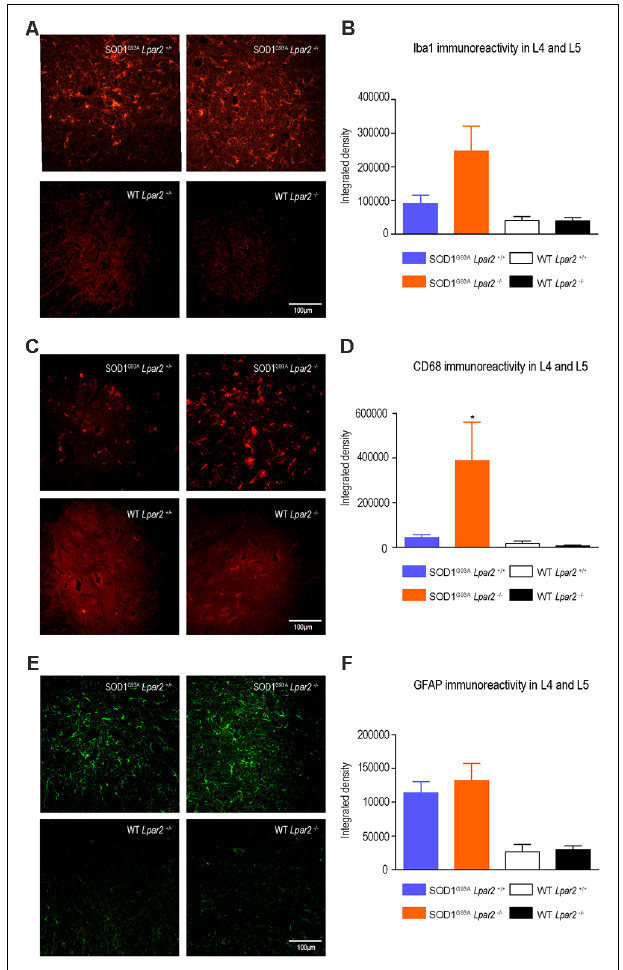
FIGURE 4 | The lack of Lpar2 does not reduce astrogliosis and microgliosis in the lumbar spinal cord of SOD1 G93A mice. (A) Representative images of the lumbar spinal cord stained against Iba1. (B) Plot showing the quantification of the Iba1 immunoreactivity in the L4 and L5 spinal cord segments. (C) Representative images of the lumbar spinal cord showing stained against CD68. (D) Graph showing quantification of CD68 immunoreactivity in the L4 and L5 segments. (E) Representative images of the lumbar spinal cord showing stained against GFAP. (F) Graph showing quantification of GFAP immunoreactivity in the L4 and L5 segments. One-way ANOVA, Bonferroni’s post hoc test. * p < 0.05 vs. SOD1 G93A LPA 2+/+ (males; n = 3 SOD1 G93A Lpar2 +/+ , n = 4 SOD1 G93A Lpar2 − / − , n = 4 WT Lpar2 +/+ , n = 4 WT Lpar2 − / − ). Data are shown as mean ±